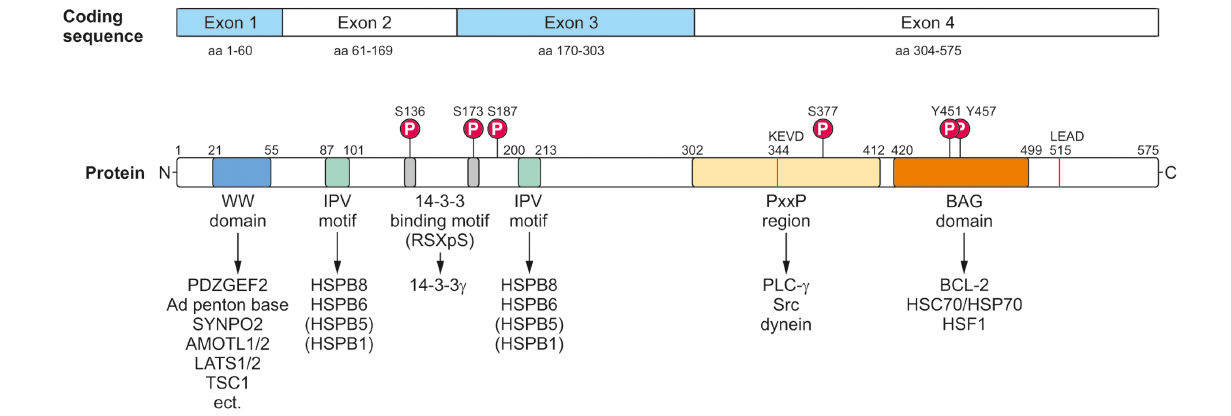
FIGURE 3 | Modular protein structure of BAG3. BAG3 is encoded by four exons (Coding sequence). The BAG3 protein comprises various characteristic amino acid motifs/regions and domains which permit the interaction of BAG3 with numerous proteins involved in many cellular key pathways. In addition to its conserved BAG domain, BAG3 contains a conserved WW domain, two IPV motifs, two 14-3-3 binding motifs and a PxxP region. Moreover, a caspase cleavage site was identified in the PxxP region ( 344 KEVD) of BAG3 and at its very C-terminus ( 515 LEAD). The BAG3 protein is suggested to be phosphorylated at the indicated serine and tyrosine